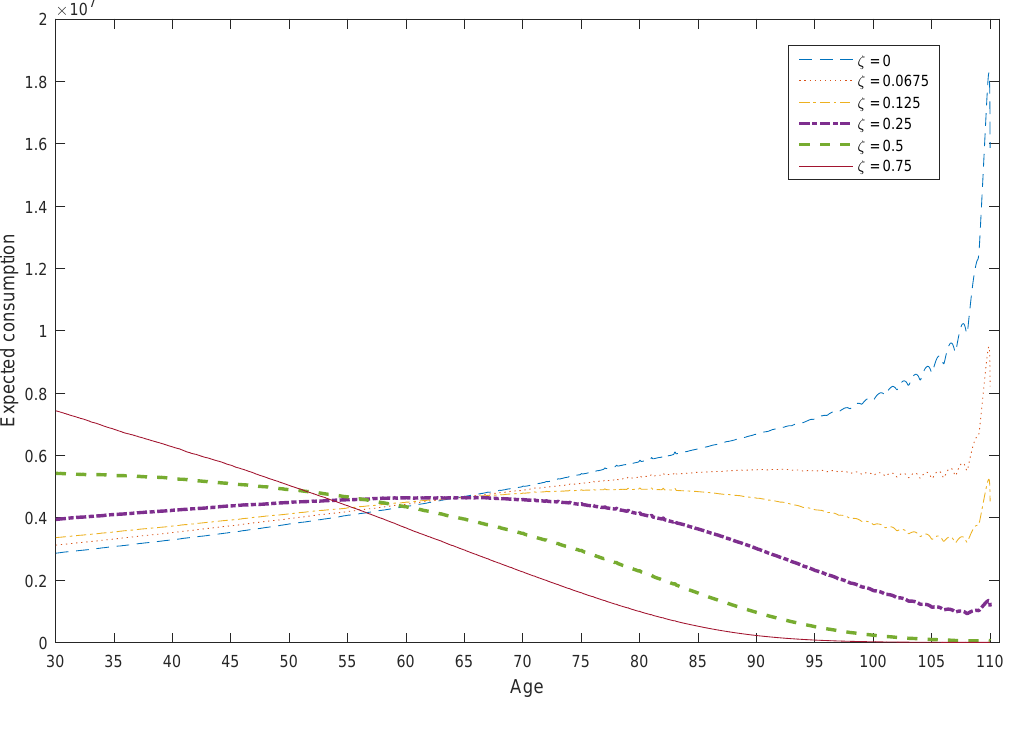
Figure 1. Expected consumption for different ζ